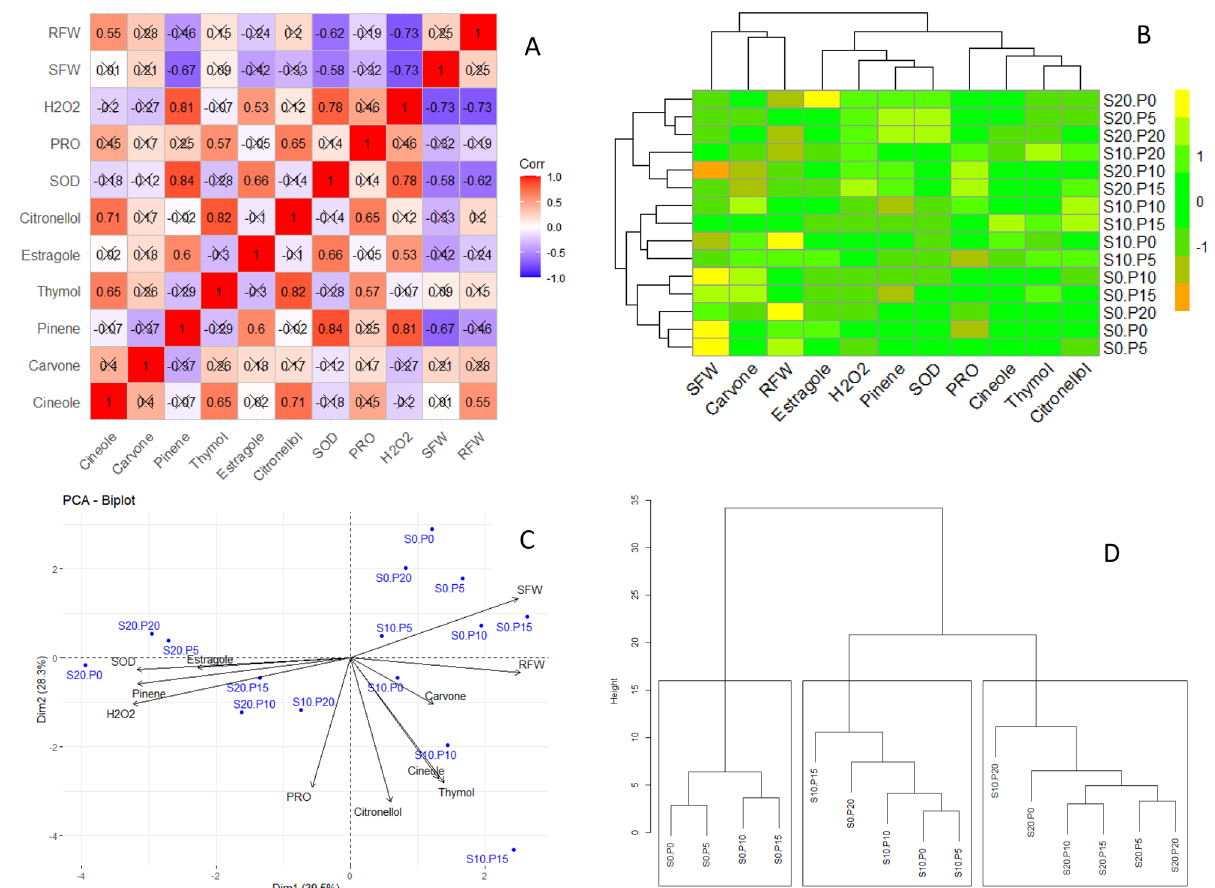
Figure 1. Correlation plot ( A ), heatmap ( B ), biplot ( C ), and clustering ( D ) of the essential oils contents and measured features in surahalala plants under PEG and Proline treatments. The analyses have been conducted on the average of the 8 replications in the experiment. S0_p0: 0% PEG and 0 µm proline; s0_p5: 0% PEG and µm proline; s0_p10: 0% PEG and 10 µm proline; s0_p15: 0% PEG and 15 µm proline; s0_p20: 0% PEG and 20 µm proline; s10_p0: 10% PEG and 0 µm proline; s10_p5: 10% PEG and 5 µm proline; s10_p10: 10% PEG and 10 µm proline; s10_p15: 10% PEG and 15 µm proline; s10_p20: 10% PEG and 20 µm proline; s20_p0: 20% PEG and 0 µm proline; s20_p10: 20% PEG and 10 µm proline; s20_p15: 20% PEG and 15 µm proline; s20_p20: 20% PEG and 20 µm proline; SOD: superoxide dismutase activity; PRO: proline content; H2O2: hydrogen peroxide; SFW: shoot fresh weight; RFW: root fresh